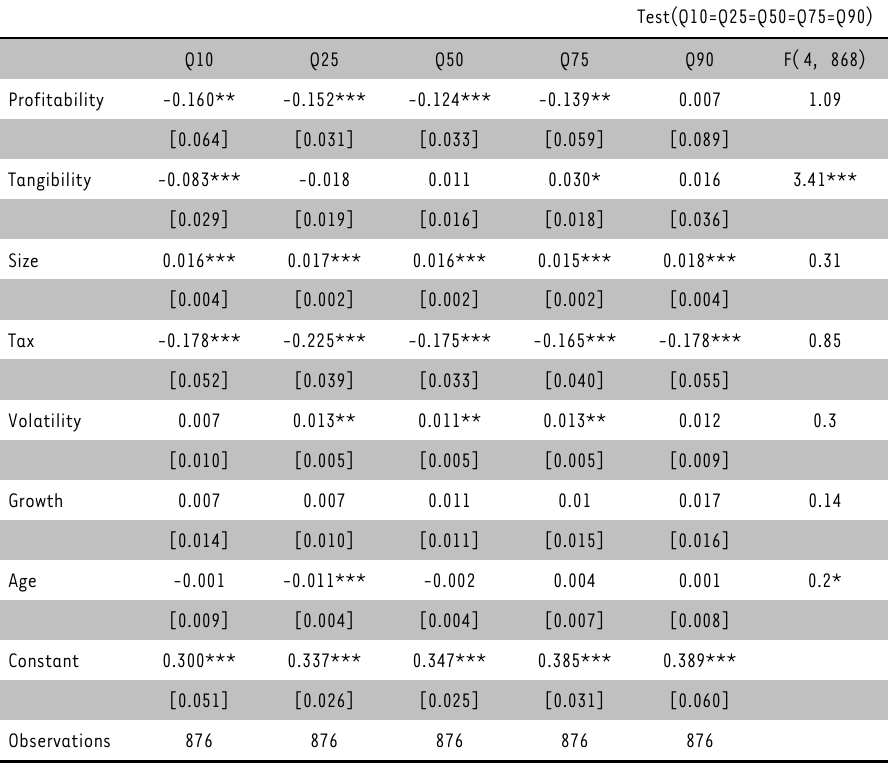
TABLE 2: Results when using Total Debt Ratio (TDR) as the Dependent